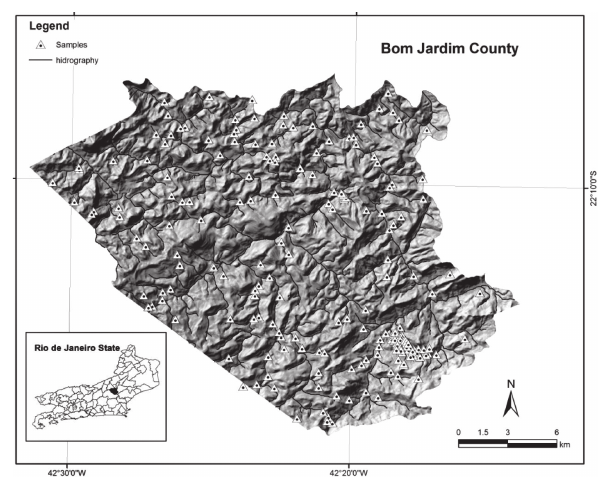
Figure 1. Study area and location of soil sampling